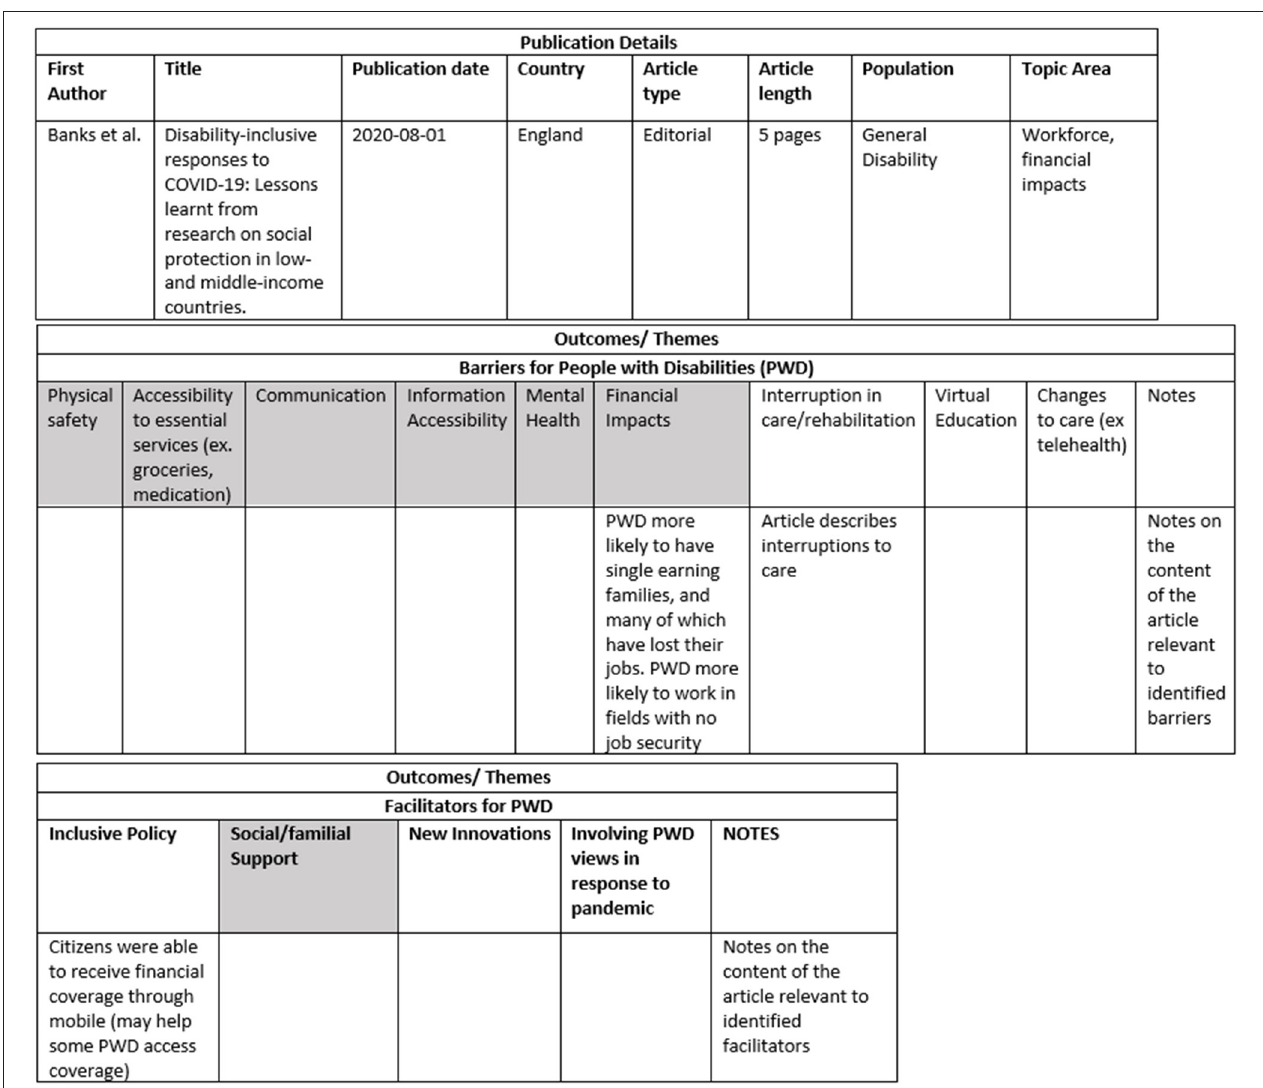
FIGURE 3 | Data-charting template used by the authors. Data charting included three sections: Publication details, Barriers for people with a disability (PWD) and Facilitators for PWD. Barriers and Facilitators in grey in the table represent existing barriers identified by the WHO and additional barriers/facilitators that emerged from the data in are white. This figure includes the data charting for one article by Aishworiya et al. (16), and notes are not included in this example of the data charting as they are